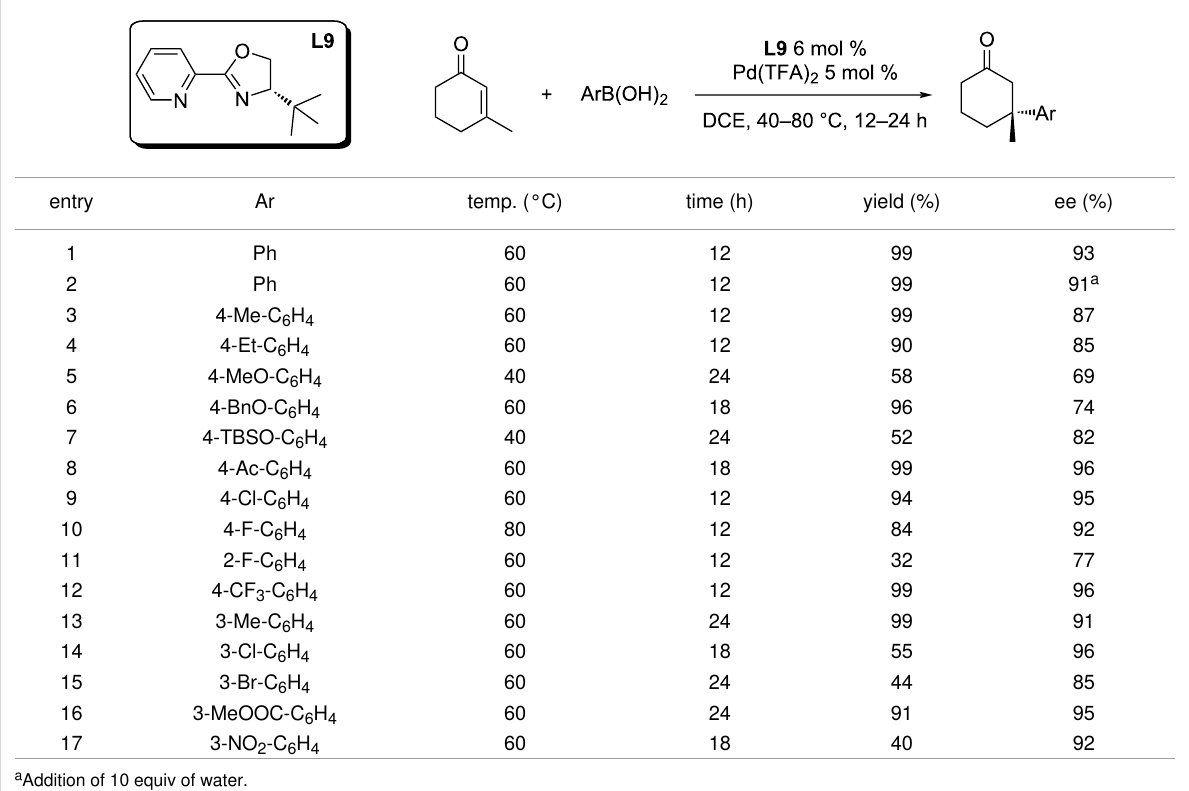
Table 17: Addition reaction of arylboronic acids to 3-methyl-2-cyclohexenone catalysed by L9 /Pd(TFA) 2 [47,49].